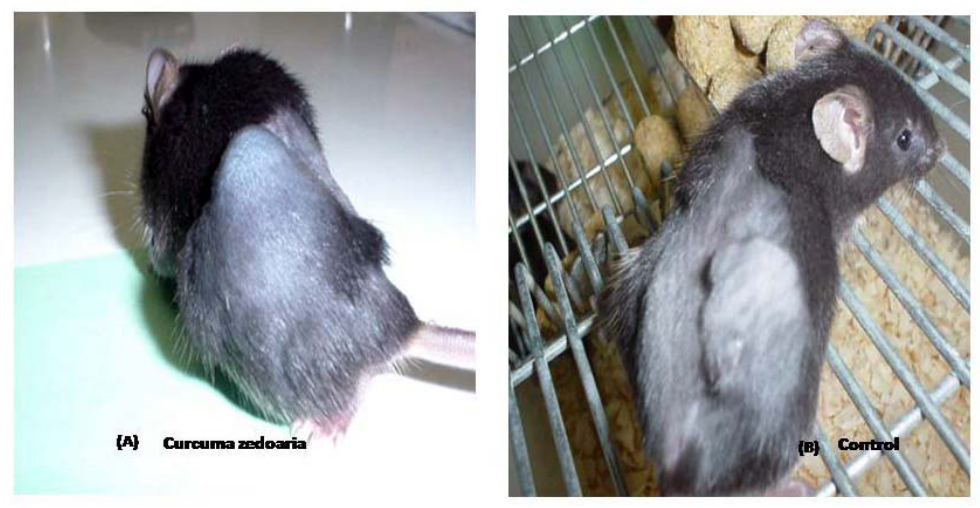
Figure 8. Effects of Curcuma zedoaria on subcutaneous B16F10 tumor growth. B16F10 melanoma cells (5 x 10 4 /mouse) were subcutaneously injected in the dorsal region of C57BL/6J mice, in the absence (controls) or presence of C. zedoaria extract (0.2%). The tumor volumes were monitored by periodic caliper measurement. ( A ) Group treated with C. zedoaria and ( B ) control